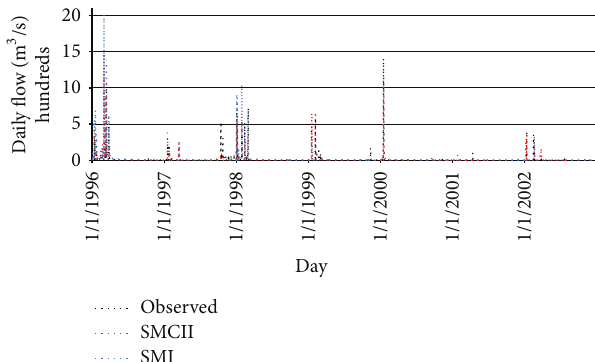
Figure 2: Daily observed and simulated stream flow (m 3 /s) by SMI and SMCII methods during model calibration.